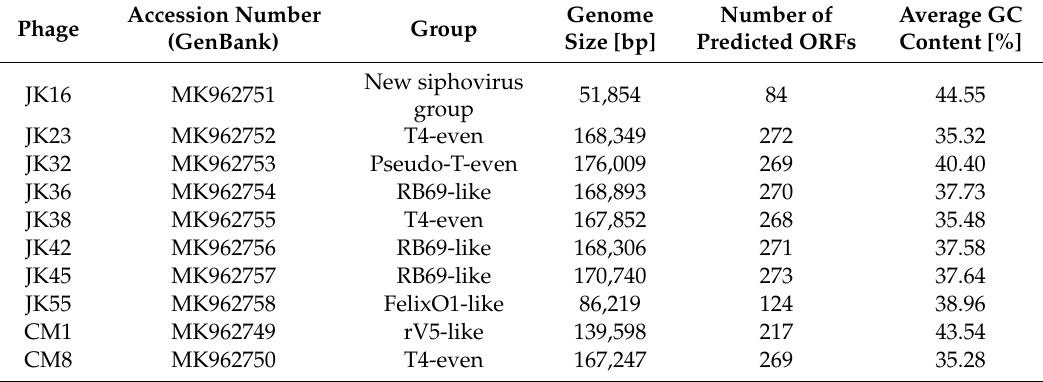
Table 3. Genome characteristics and Genbank accession information of the ten sequenced isolates in this